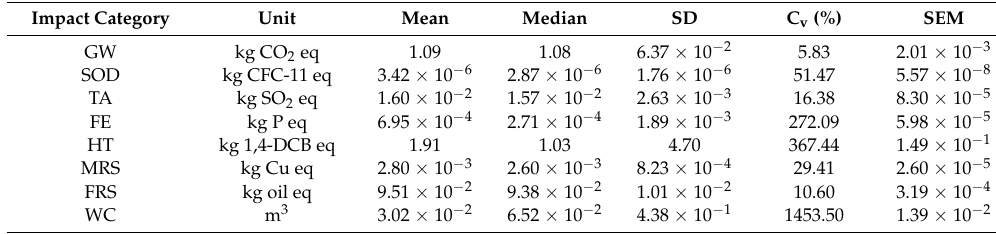
Table 6. Results of Monte Carlo uncertainty analysis related to the membrane upgrading